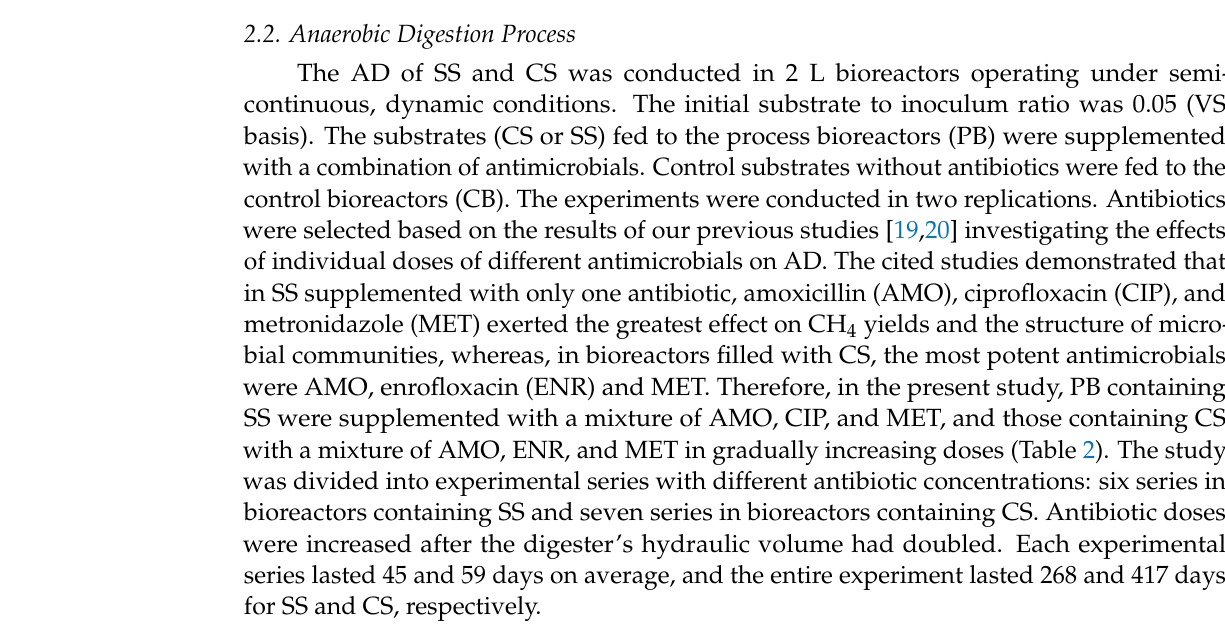
Table 2. Concentrations of antimicrobials (Dose ID) added to SS and CS in successive experimental